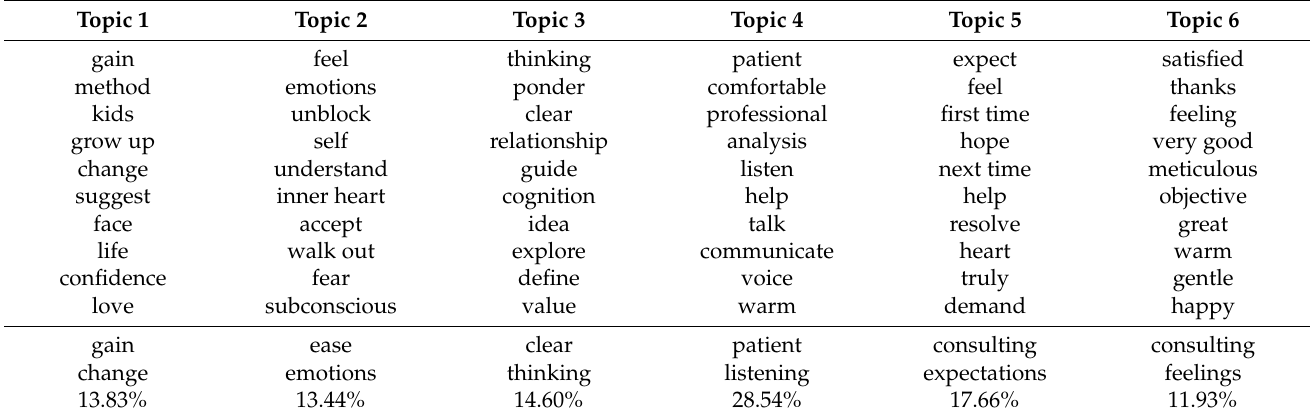
Table 3. Topic analysis